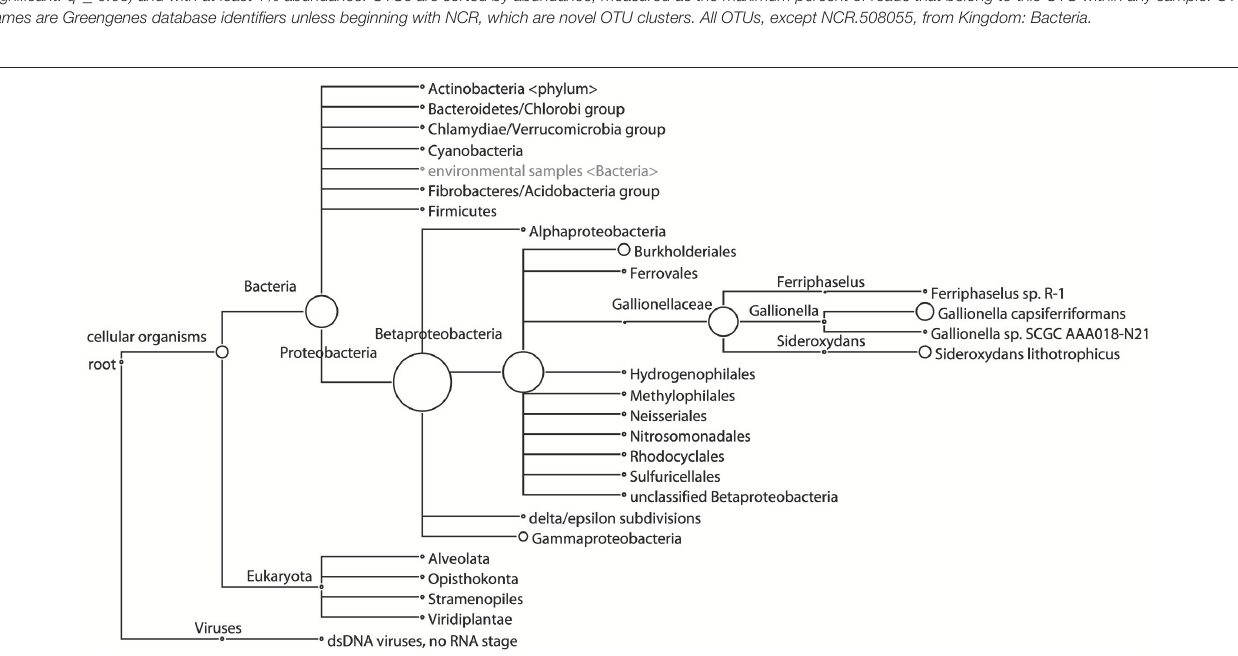
List of OTUs with abundance levels significantly correlated with copper concentration according to Pearson’s correlation with Benjamini-Hochberg false discovery rate correction (significant: q ≤ 0.05) and with at least 1% abundance. OTUs are sorted by abundance, measured as the maximum percent of reads that belong to this OTU within any sample. OTU